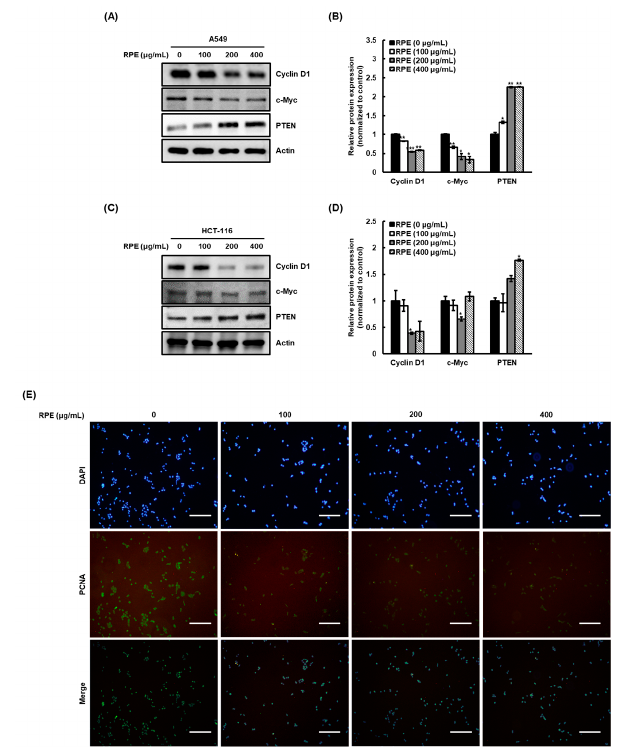
Figure 2. Effect of RPE on expression of proliferation-related protein in A549 and HCT116 cells. These cells were treated with RPE at a concentration of 0, 100, 200, or 400 μ g/mL for 24 h. The expression of cyclin D1, c-myc, and PTEN of ( A , B ) A549 and ( C , D ) HCT116 cells were detected by Western blotting and densitometric analysis. β -actin was used as loading control. Relative expression is represented as means ± standard deviation ( n = 3) as * p < 0.05, ** p < 0.01, *** p < 0.005, compared with untreated group. ( E ) The expression of PCNA of A549 cells was observed by immunofluorescence staining, and then representative images were indicated. Size of the scale bar in the images refer to 100 µ